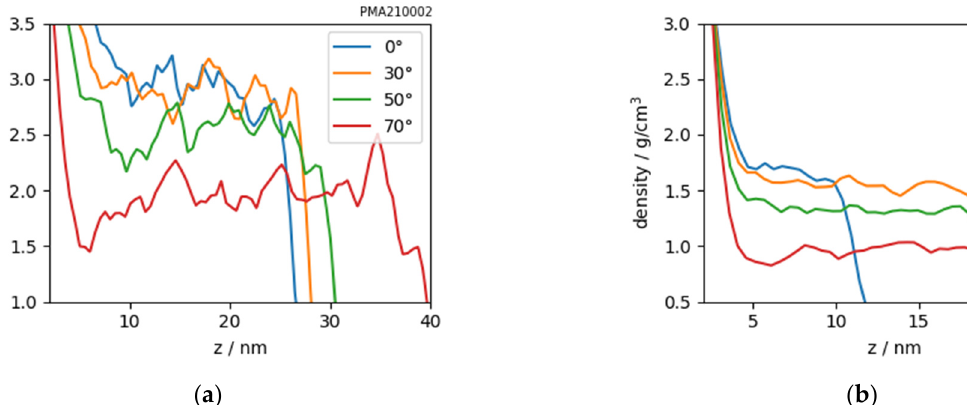
Figure 4. Density in growth direction z of TiO 2 for small ( a ) and large ( b ) structures with a resolution of 0.5 nm in z. The reduction of the density from small to large structures results not only from the change of the structure size but also from the change of the potential used.